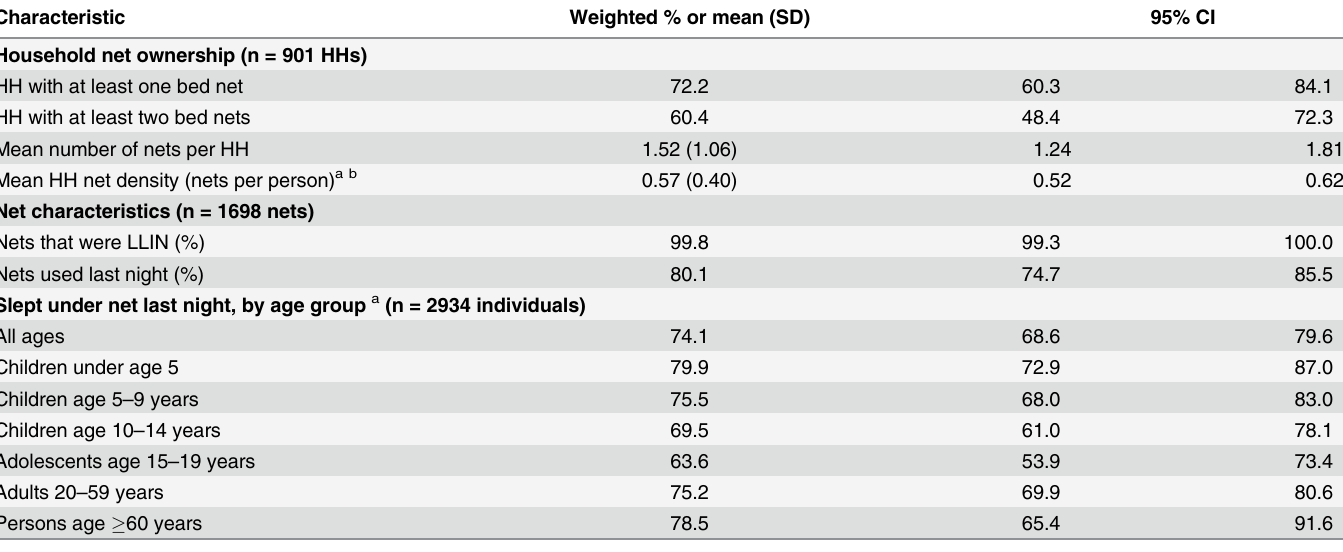
Table 1. Weighted estimates of net ownership and use in 2 LGAs of Ebonyi state, Nigeria, November 2011. HH: Household; LLINs: Long-lasting insecticide treated nets; SD: Standard